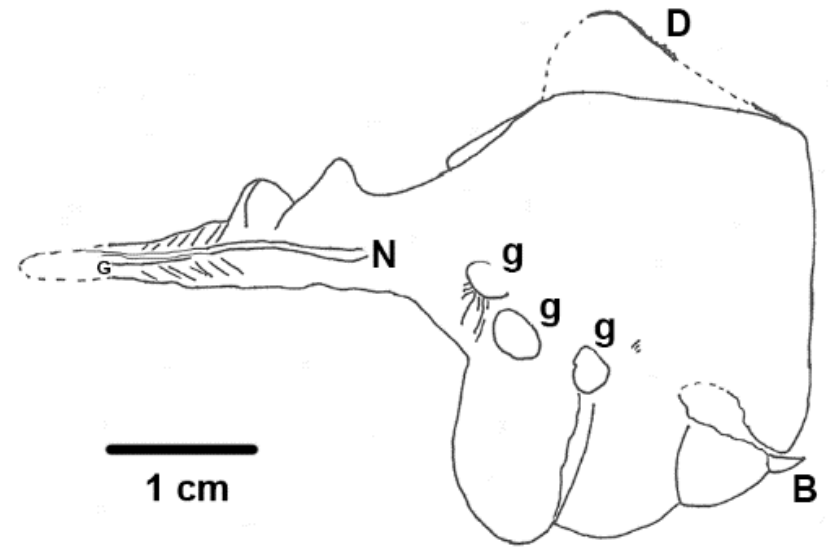
Figure 15. Shenzianyuloma yunnanense nov. gen. nov. sp. IGM 5008. Line art sketch showing morphology of the specimen. B , wedge beak; D , dorsal fin with denticulate leading margin; g , gill structure; G , presumed gut trace; N , notochord. Scale bar 1 cm. Image Credit: Mark McMenamin.